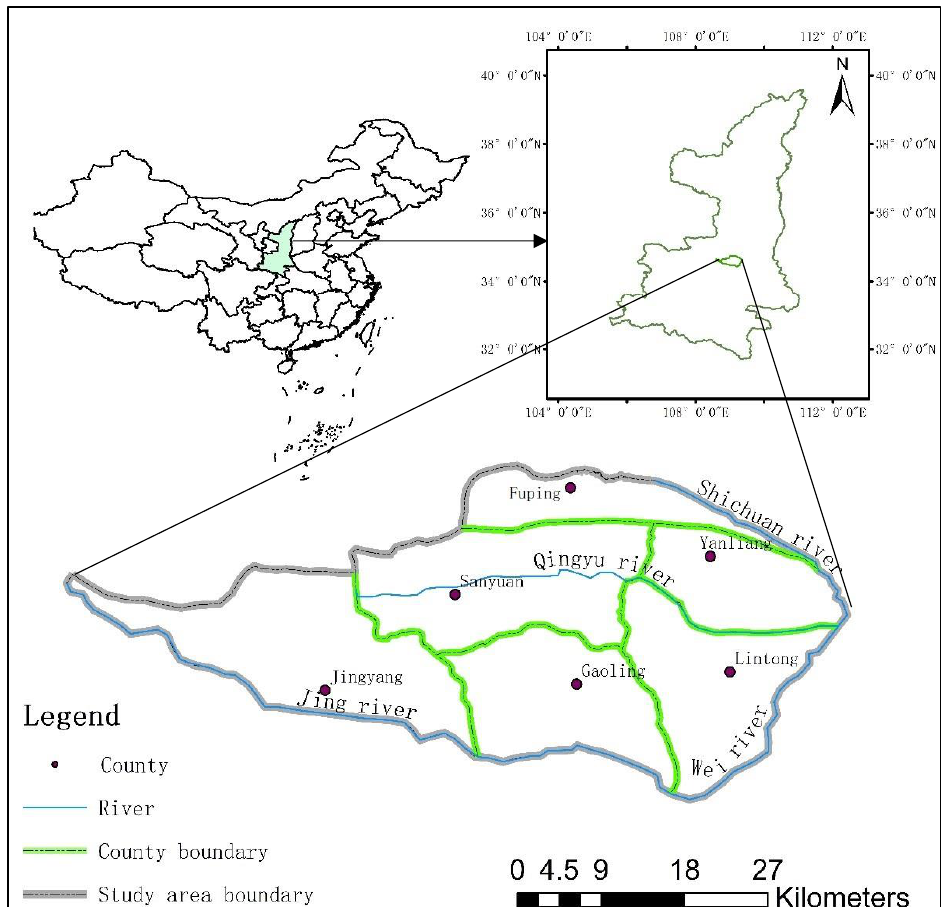
Figure 1. Location of the Jinghui irrigation district.